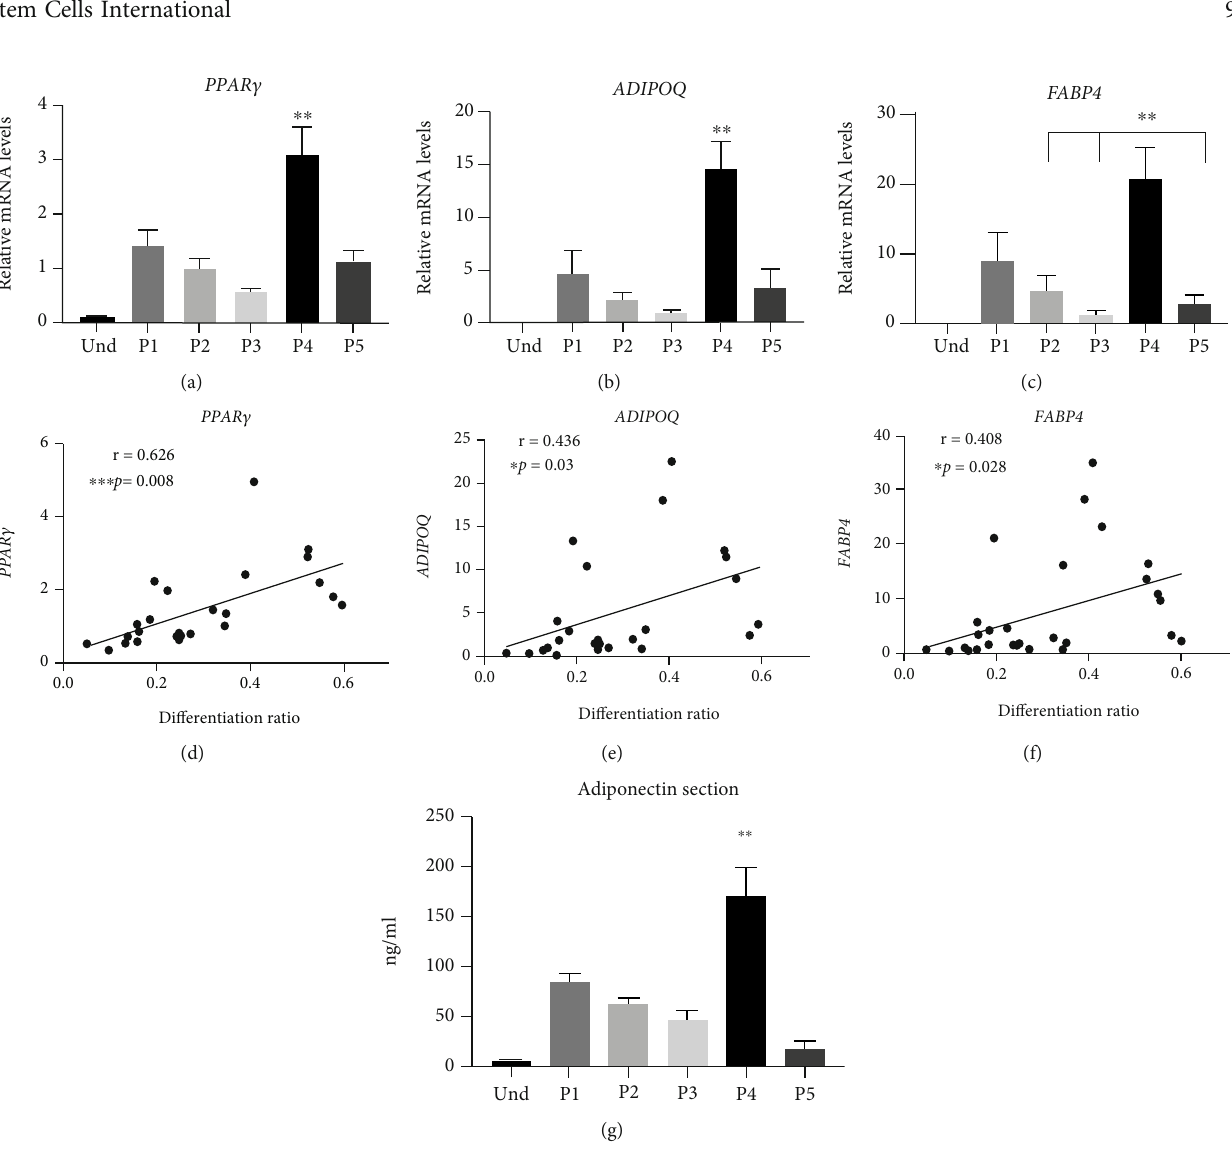
Figure 2: E ff ect of the di ff erentiation protocols on adipogenesis gene expression. Human adipose-derived stem cells were di ff erentiated for 21 days with fi ve adipogenic di ff erentiation protocols. Relative mRNA expression of nuclear-encoded genes (a) PPAR γ , (b) ADIPOQ , and (c) FABP4 was measured by RT-qPCR. Results were normalized to the expression of reference genes IPO8 and GUSB using qBASE software. Statistical analysis was performed using one-way ANOVA followed by Tukey ’ s post hoc analysis ( n = 6 ): ∗∗ p < 0 : 01 . Error bars are shown as SEM. Expression correlation for relative mRNA expression of (d) PPAR γ , (e) ADIPOQ , and (f) FABP4 with the di ff erentiation ratio. Statistical analysis was performed using the Pearson correlation ( n = 6 ): ∗ p < 0 : 05 , ∗∗∗ p < 0 : 001 . (g) Secretion of adiponectin to the cell culture media. Statistical analysis was performed using one-way ANOVA followed by Tukey ’ s post hoc analysis ( n = 5 ): ∗∗ p < 0 : 01 . Error bars are shown as SEM. The statistical di ff erences in (a), (b), and (g) indicate a comparison with all the other